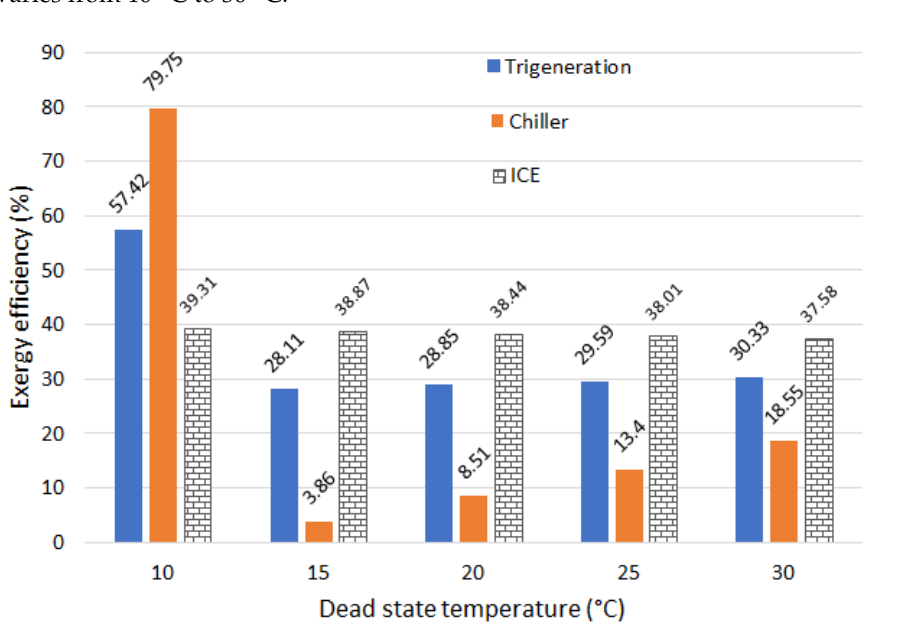
Figure 2. Dead state temperature vs. exergy